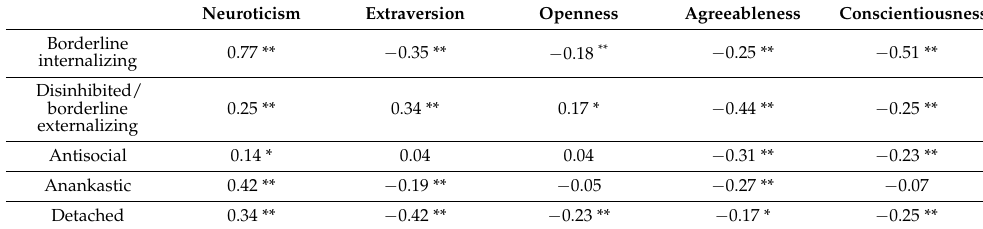
Table 1. Correlations between extracted PD domain factors in previous study and FFM factors.